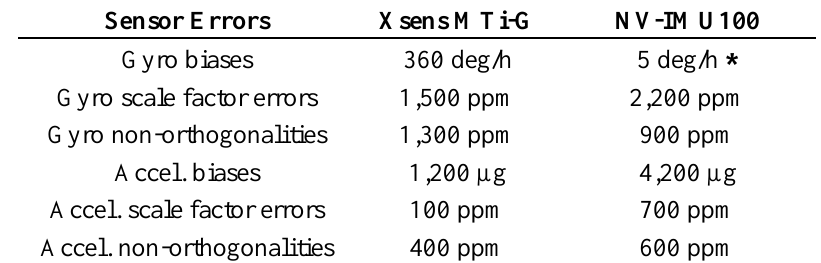
Table 12. Accuracy of proposed method (reference to Soak method).